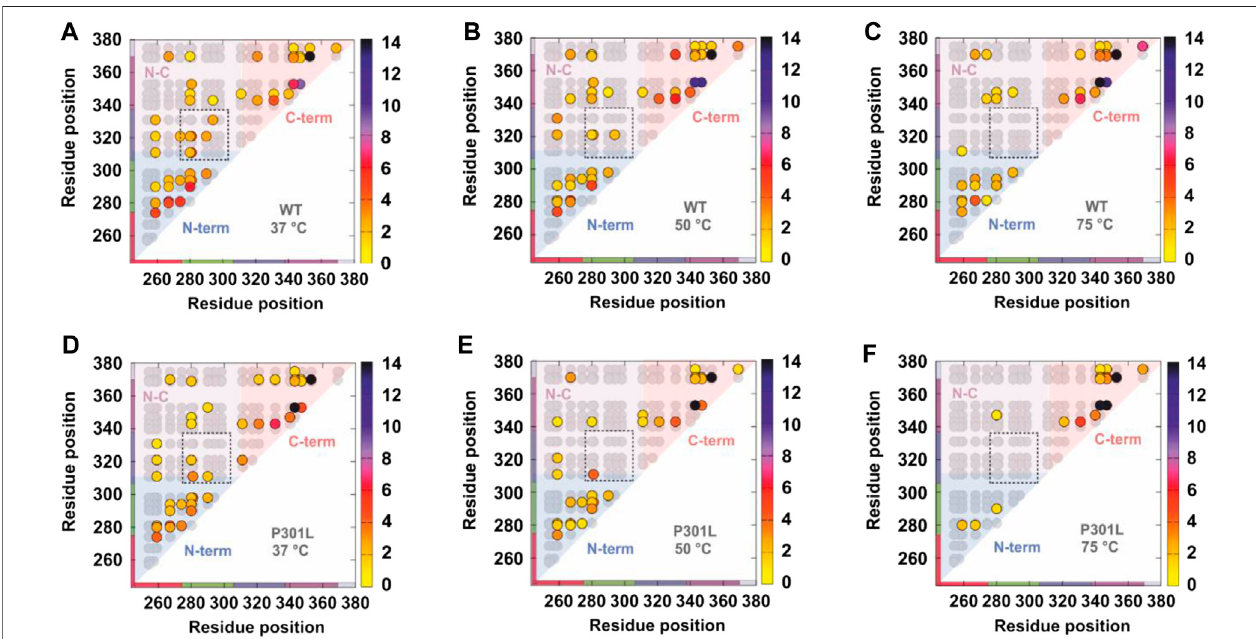
FIGURE 5 | Comparative crosslinking of the tau repeat domain. Contact maps showing all theoretical crosslinks (Lys-Lys pairs) in the tau repeat domain (gray circles) and the detected crosslinks (colored circles). (A – C) Detected crosslinks in the wild type tau repeat domain at (A) 37 ° C, (B) 50 ° C, and (C) 75 ° C. (D – F) Detected crosslinks in the P301L tau repeat domain at (A) 37 ° C, (B) 50 ° C, and (C) 75 ° C. The detected crosslinks are colored according to the frequency by which they were observed — the scale is shown on the right hand side of each panel. The contact maps are shaded to denote crosslinks within the N-terminus (blue), C-terminus (red), and between the N- and C-termini (pink). Note that fewer long range contacts are observed with increasing temperature and that the P301L mutation promotes extended states (fewer long range crosslinks). Figure reproduced from (Chen et al.,